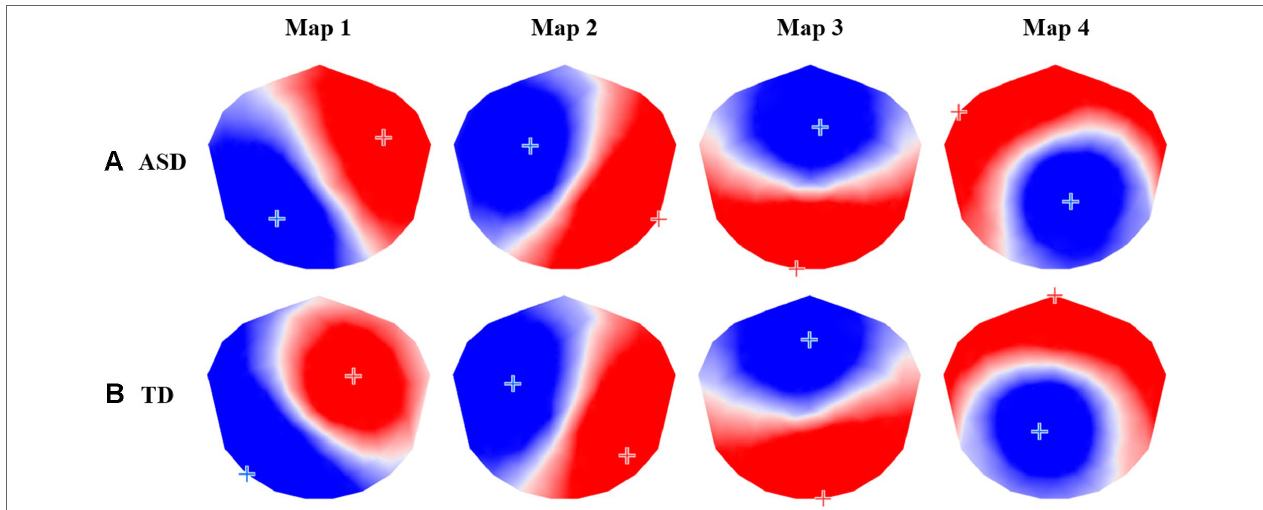
FIGURE 2 | The four prototypic maps identified by the group-level k-means cluster analysis for (A) autism spectrum disorder (ASD) and (B) typically developing (TD) participants.